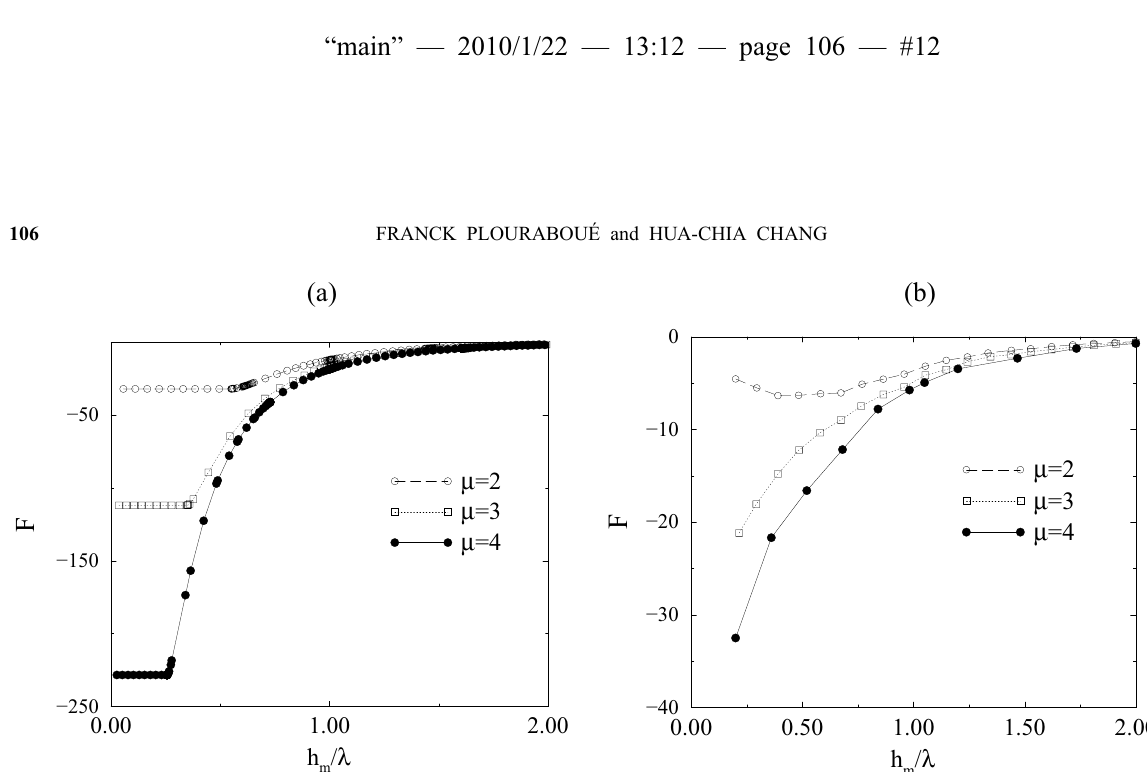
Fig. 3 – Dimensionless Force computed versus the minimum-gap to Debye layer ratio for a different value of the mixed bound- ary condition parameter μ . (a) Between two spheres, (b) between two